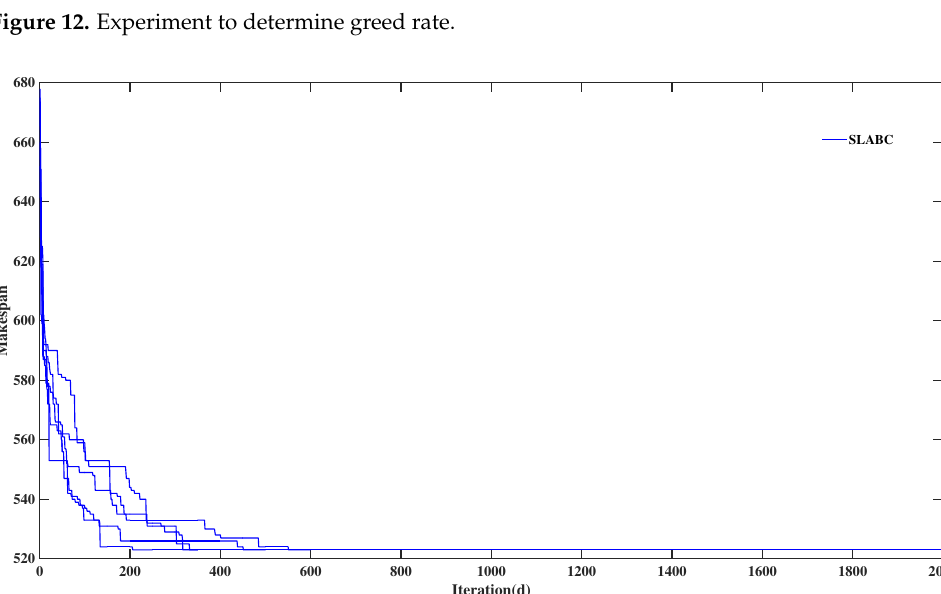
Figure 12. Experiment to determine greed rate.